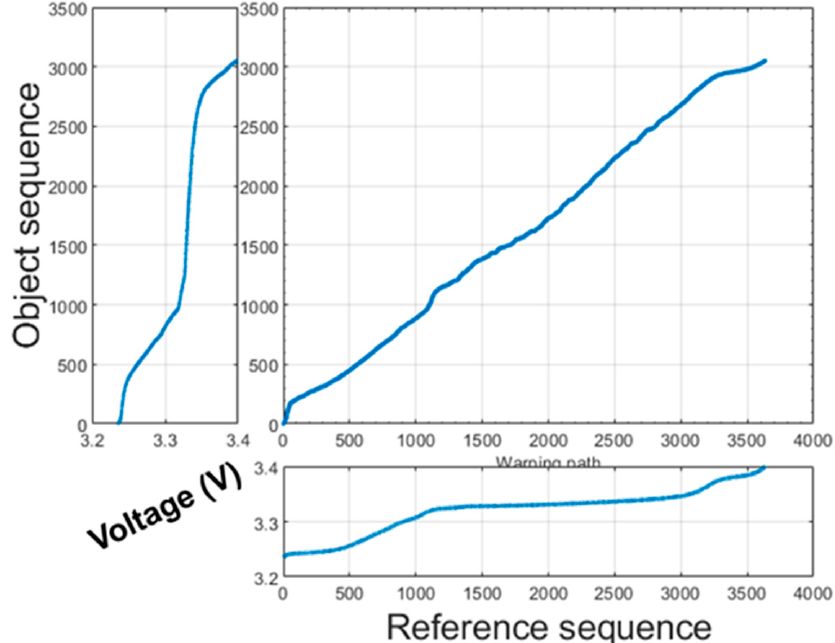
Figure 7. The curve-matching example.